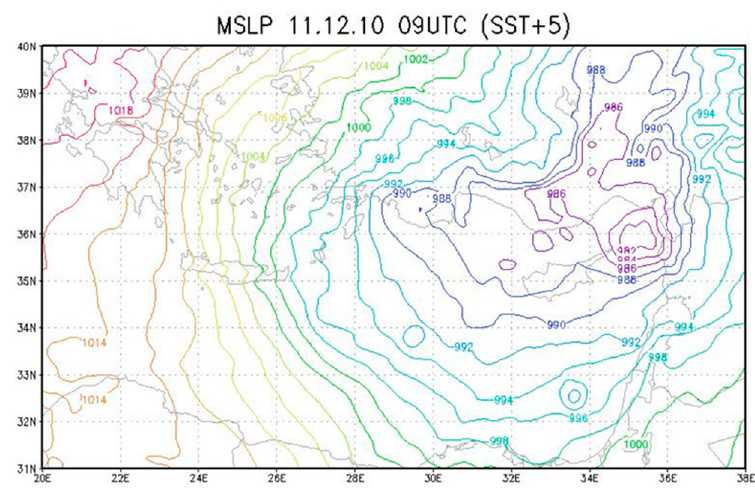
Figure 30. MSLP at 11 December 2010 09 UTC for the +5 °C SST anomaly run.